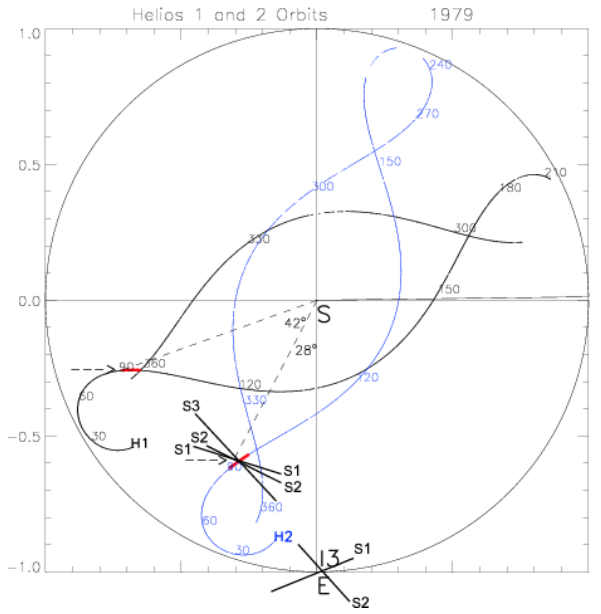
Fig. 1. The trajectories of Helios-1 (black trace) and Helios-2 dur- ing 1979, shown in a system with a fixed Sun-Earth line. The near- Earth spacecraft ISEE-3 is marked I 3. The ecliptic projections of the shock fronts at both locations are also